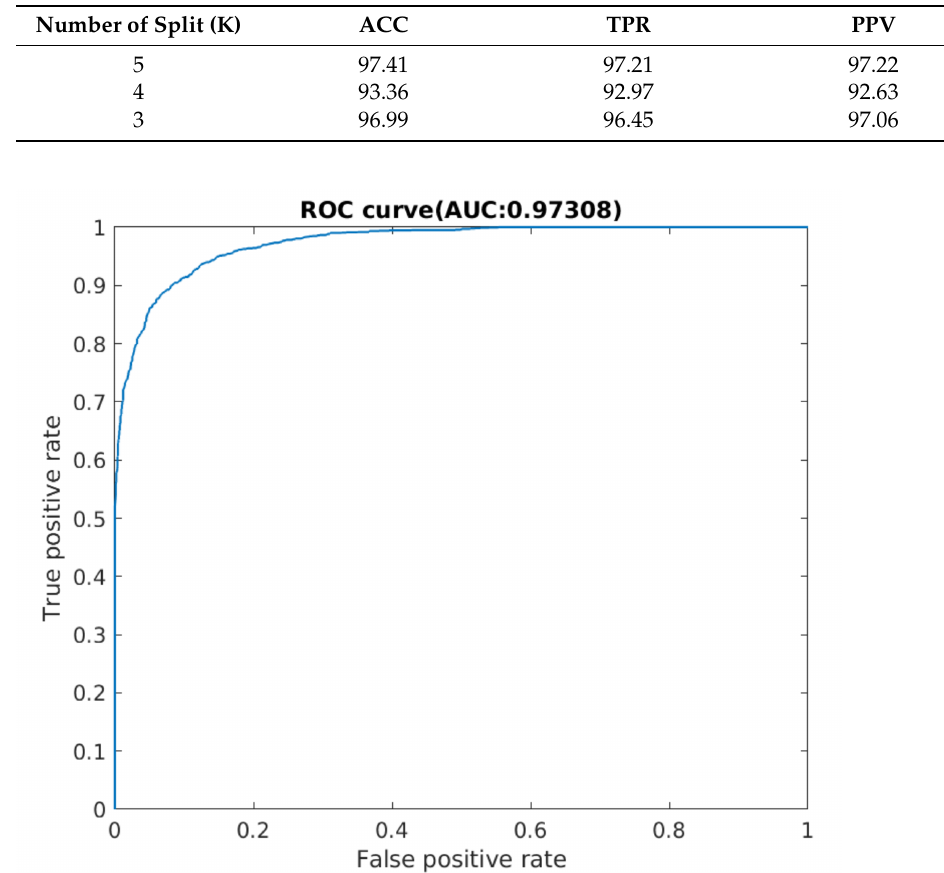
Figure 13. ROC curves for gender estimation results for the Adience benchmark.